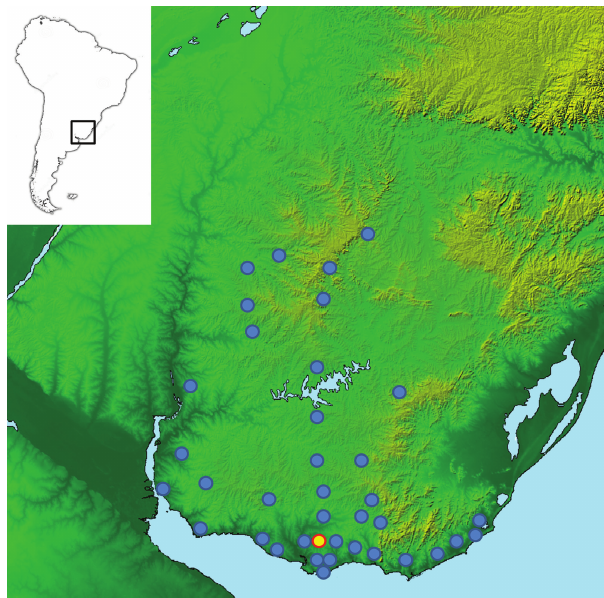
Fig. 6 . Distribution of Gymnogeophagus terrapurpura . Yellow dot indicates type locality. Map modified from Shuttle Radar Topography Mission (SRTM), Courtesy